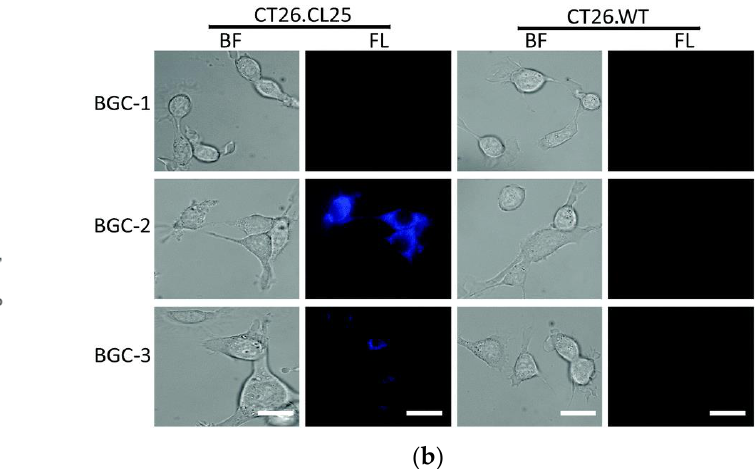
Figure 13. ( a ) Probes BGC-1, -2, and -3. ( b ) Fluorescent imaging in live CT26.CL25 and CT26.WT cells. Adapted from [58] with permission